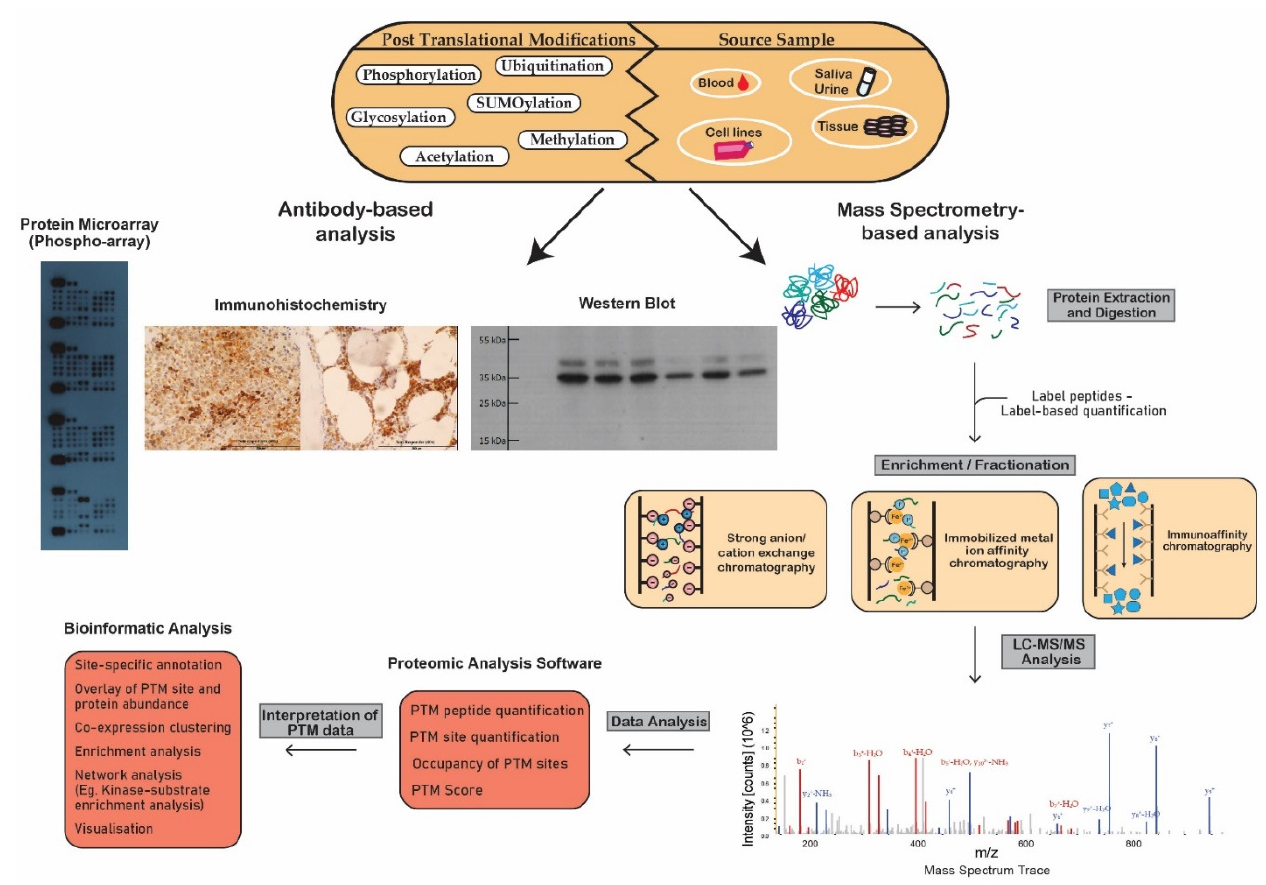
Figure 2. Schematic workflow illustrating analytical techniques used in the analysis of post-translational modifications. Proteomic techniques used for PTM analysis can be divided into antibody-based analysis or mass spectrometry (MS)-based analysis. Protein microarrays, immunohistochemistry and Western blot analysis demonstrate widespread popularity as efficient tools for antibody-based PTM analysis. MS-based analysis is a powerful technique in the study of PTMs. This figure outlines the steps involved in the preparation of crude samples for MS and the transformation of MS data into interpretable results.